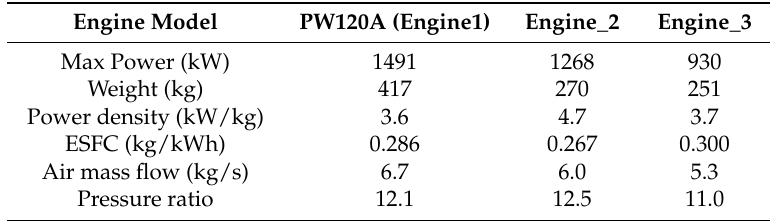
Table 3. Gas turbine parameters.